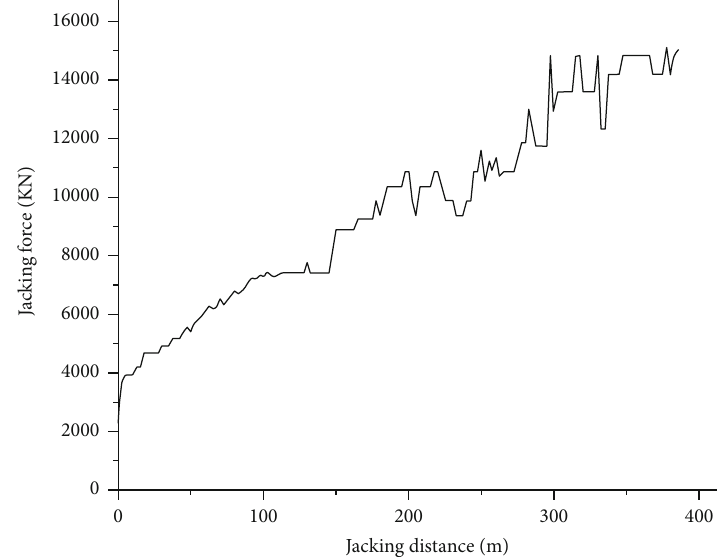
Figure 11: Measured jacking force and friction resistance on